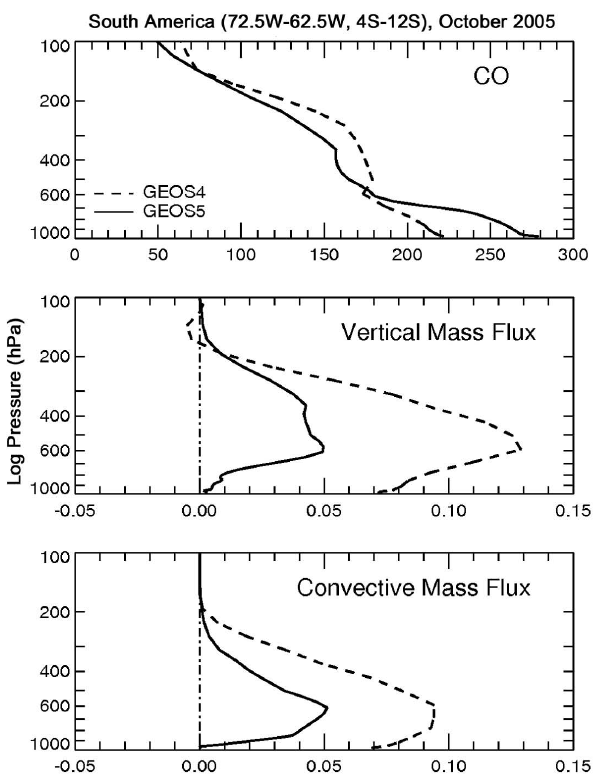
Fig. 12. Vertical profiles of CO (top), total air mass flux (middle), and convective mass flux (bottom) in October 2005 at the center of the biomass burning region in South America (72.5 ◦ W–62.5 ◦ W, 4 ◦ S–12 ◦ S) for simulations driven by GEOS-4 (dashed) and GEOS- 5 (solid). Mass flux is in Pas − 1 , CO is in ppb.